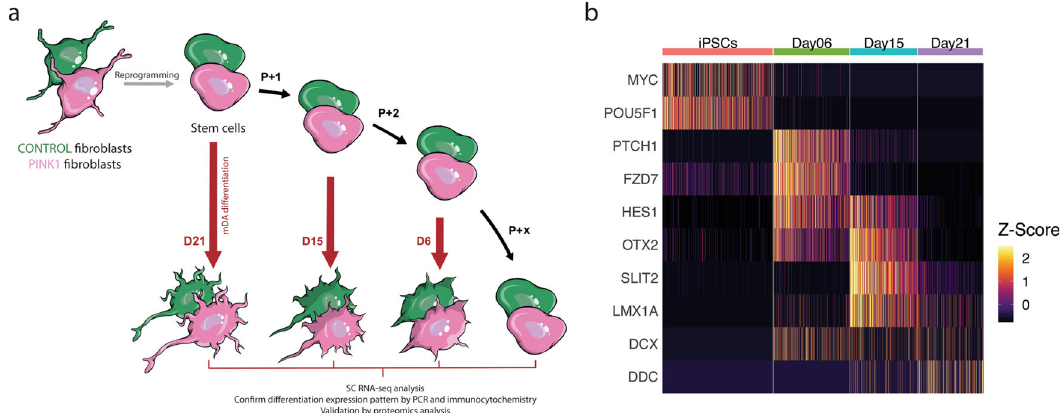
Fig. 1 Experimental design. a Fibroblasts were used to generate human induced pluripotent stem cells (iPSCs), which were then used to generate mDA neurons. Differentiation was initiated concurrently in a PINK1 -ILE368ASN and a control cell line, at three different timepoints, to obtain cells which reach different stages of differentiation on the same collection day (generating four independent pairs). The samples were collected and processed for SC- RNAseq at the same time to avoid batch effects. “ P + 1 ” indicates that the iPSCs were passaged before new differentiation was initiated. Since D10 was not used in the pairwise analysis, we indicated “ P + 2 ” between D15 and D6 differentiation initiation. b Heatmap illustrating the transitions in gene expression from iPSC markers ( MYC and POU5F1-OCT3/4 ), to genes associated with mDA differentiation ( PTCH1 , FZDZ , HES1 , OTX2 , SLIT1 , and LMX1A ), and fi nally to an early expression of mature mDA markers ( DCX and DDC ). This is discussed in more detail in the text and in Figs. 3 and 4. The gene expression matrix used here consists of 4495 cells (39,194 genes). Colors correlate to normalized counts ( z -score, centered, and scaled) of the indicated